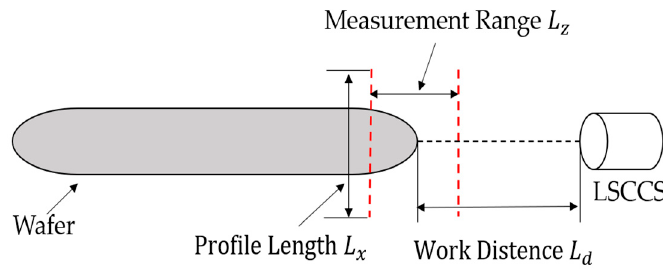
Figure 6. Characteristics of LSCCS 3D pro fi lometer.